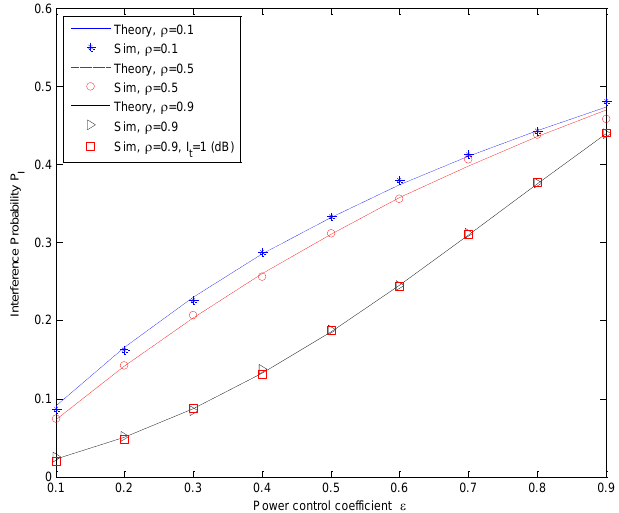
Figure 8. Interference probability P function of the transmit power control coefficient ε of the secondary user R P = 0 S-Rx